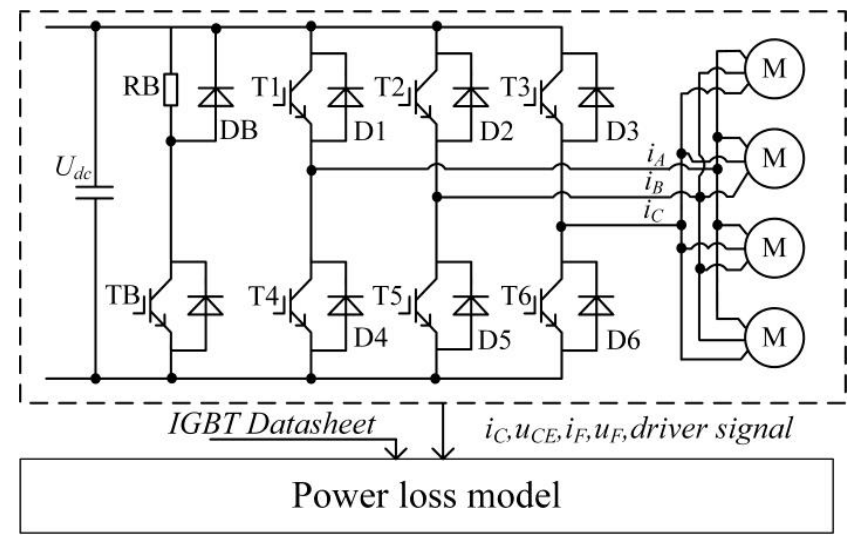
Figure 1. Power loss simulation topology of traction converter for urban rail vehicles.